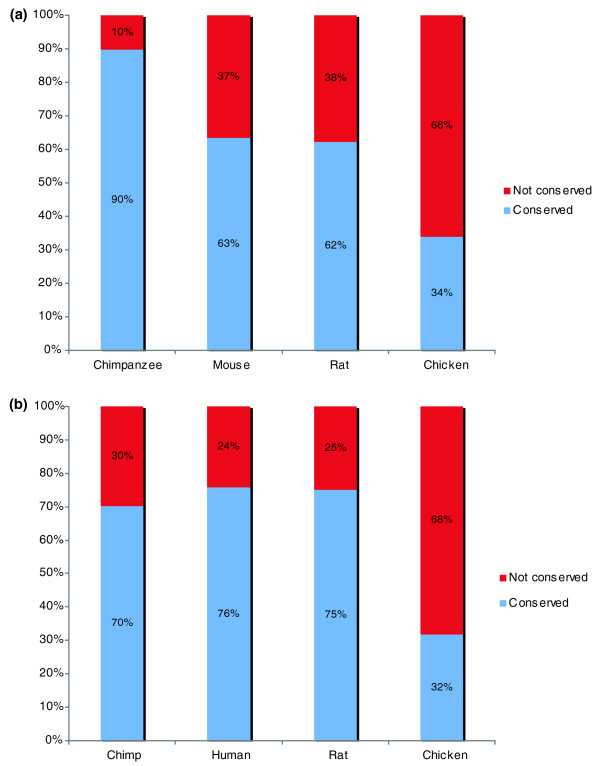
Conservation of C4 AARs from the perspective of the human and mouse protein sets. (a) Vertical bars represent proportions of tandem repeats that are present (purple) or absent (red). (b) Corresponding plot for mouse repeats.